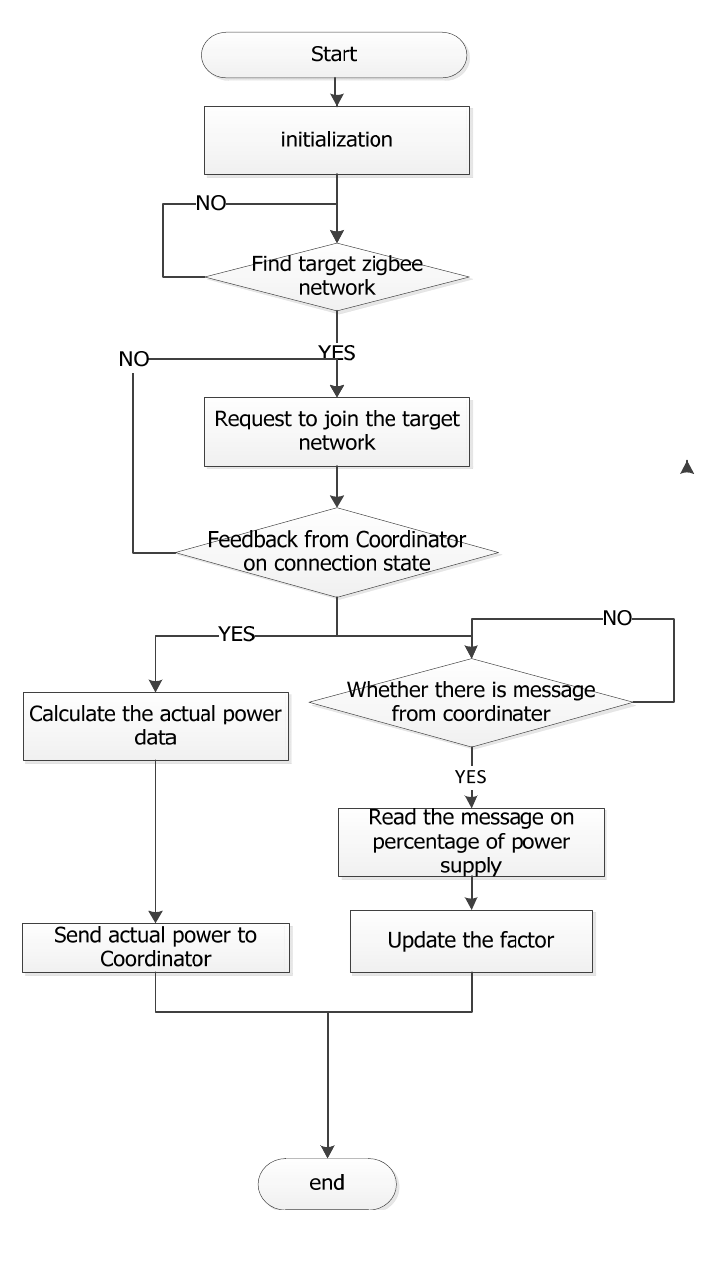
Figure 10. The activity diagram for end